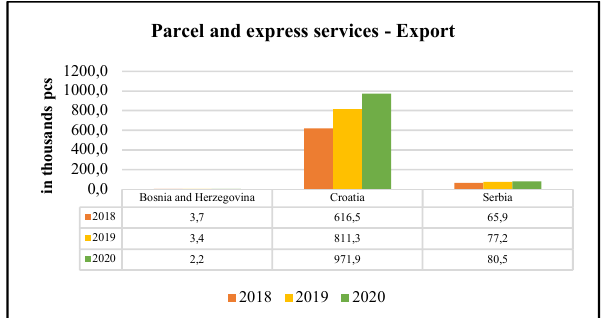
Figure 4. Parcel and express services in Export - PPO.